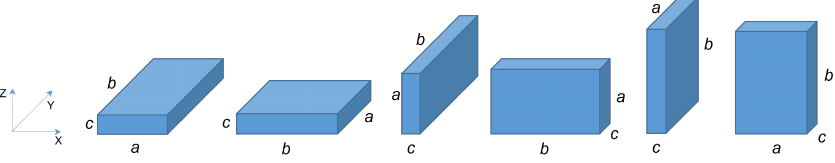
Figure 2. The possible space occupations of a parallelepiped in the 3D